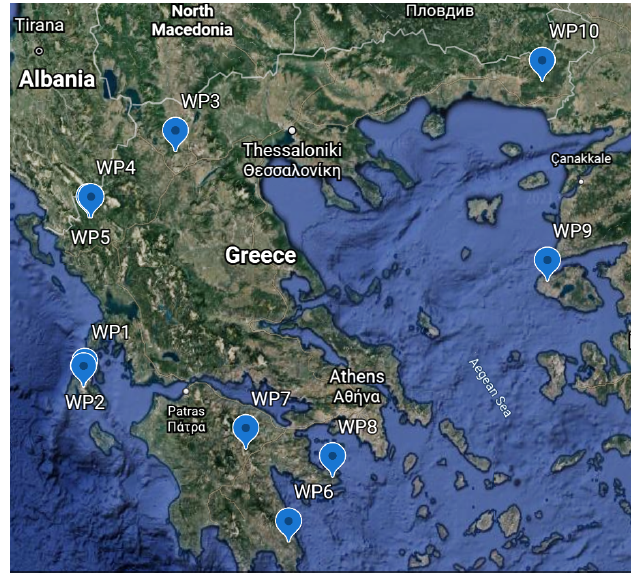
Figure 1. The locations of the 10 examined wind parks.